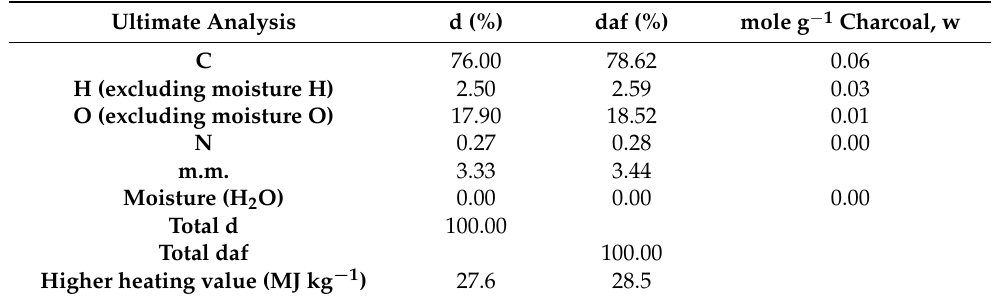
Table 5. Elemental Composition of char produced during Fast Pyrolysis of pinewood at 500 ◦